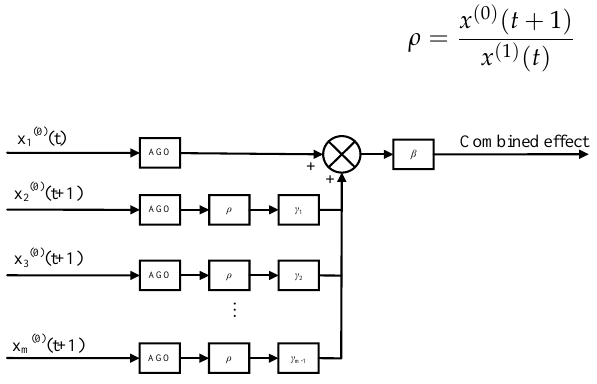
Figure 6. Details of multi-factor information collection.